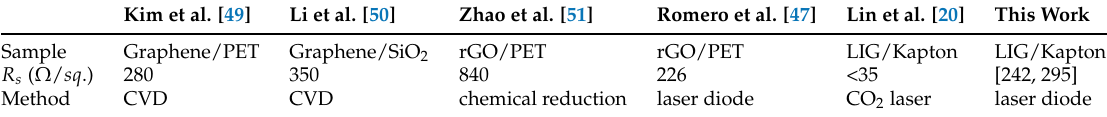
Figure 7. ( a ) total resistance extracted from the Transmission Line Method (TLM) using Ag electrodes; ( b ) sheet resistance as a function of the laser power at an excursion rate of 3 min/cm 2 . Table 2. Comparison of the sheet resistance, R s , extracted from close related graphene-derived samples. Kim et al. [49] Li et al. [50] Zhao et al. [51] Lin et al. [20] This Work